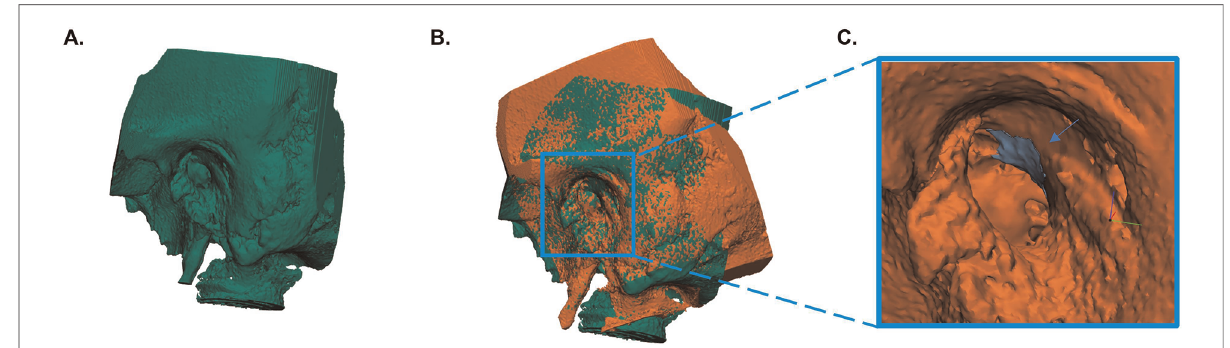
FIGURE 1 Volumetric three-dimensional (3D) evaluation of scutum removal. ( A ) Segmentation and conversion of the preoperative temporal bone images into a 3D model. ( B ) Alignment of the preoperative and postoperative 3D model. ( C ) Calculation of the bone volume of the resected scutum. The blue area represents the volume of resected scutum (see blue arrow). The orange temporal bone is the postoperative